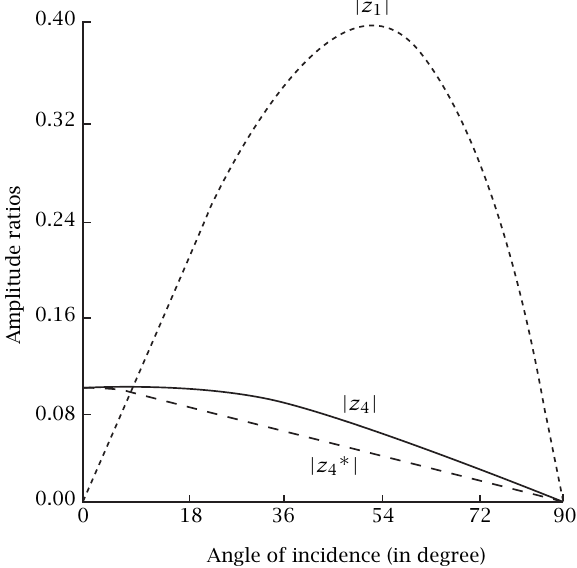
Figure 4.2 . Variation of amplitude ratios with angle of incidence of longi- tudinal